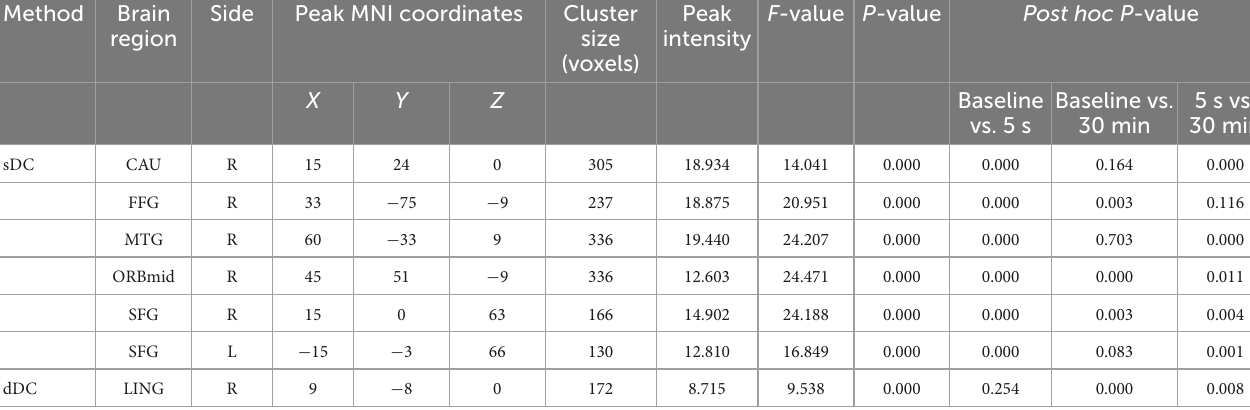
TABLE 2 sDC and dDC difference in CTN patients among different timespoints. Method Brain region